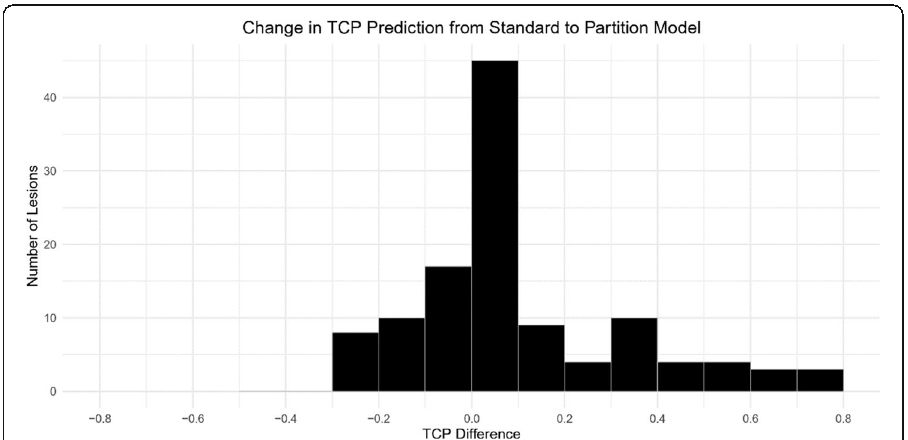
Fig. 5 Histogram of change in tumor control probability estimate for individual tumor when prescribing 75 Gy to the normal liver using the partition model vs 120 Gy to a lobe via the standard